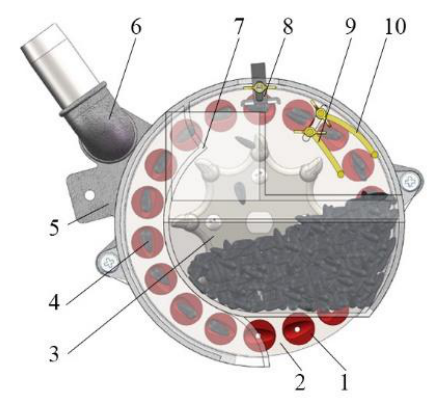
Figure 1. Schematic diagram of the air-suction sunflower seed-metering device: 1. Seed suction groove; 2. Seed-metering plate body; 3. Stirring device; 4. Sunflower seeds; 5. Air chamber; 6. Suction channel; 7. Seed box; 8. Cleaning device; 9. Lower adjusting device; and 10. Upper adjusting device.